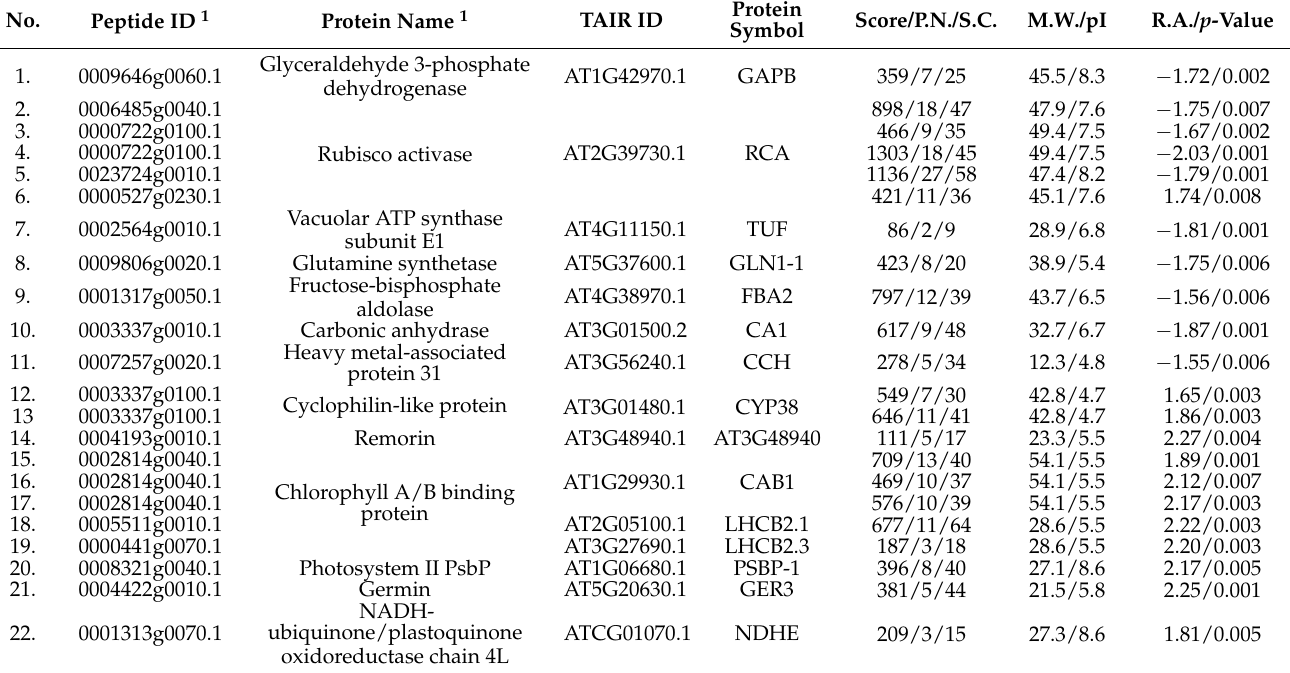
Table 1. Proteins differentially expressed between timentin-treated tobacco in vitro shoot samples collected at the early and late stages of the propagation